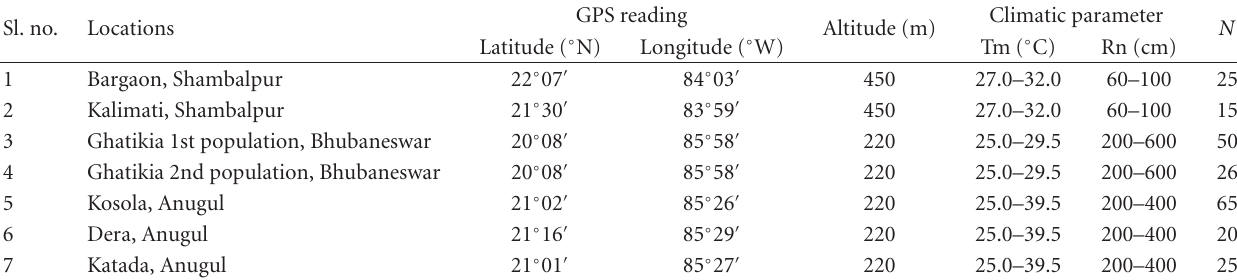
Table 1: Plants collected from di ff erent locations of Orissa, India, for diversity study. Sl.